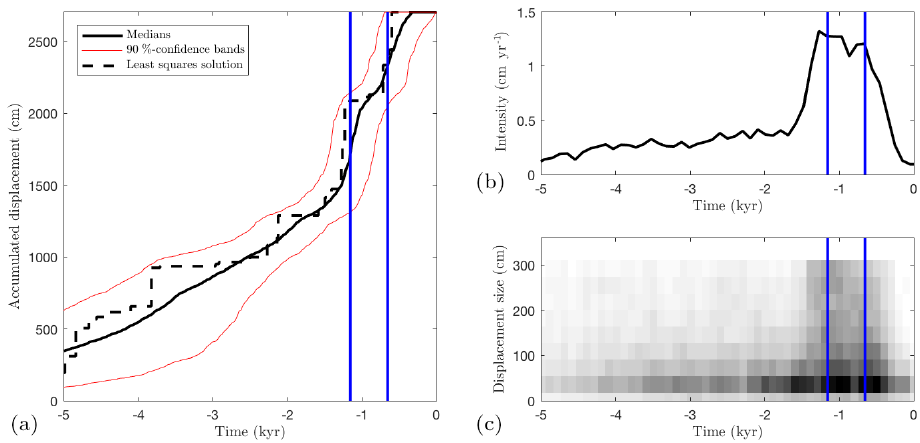
Figure 12. Fiamignano fault: detailed view of posterior displacement history and earthquake intensity. The vertical blue lines show the timings of two events that damaged the